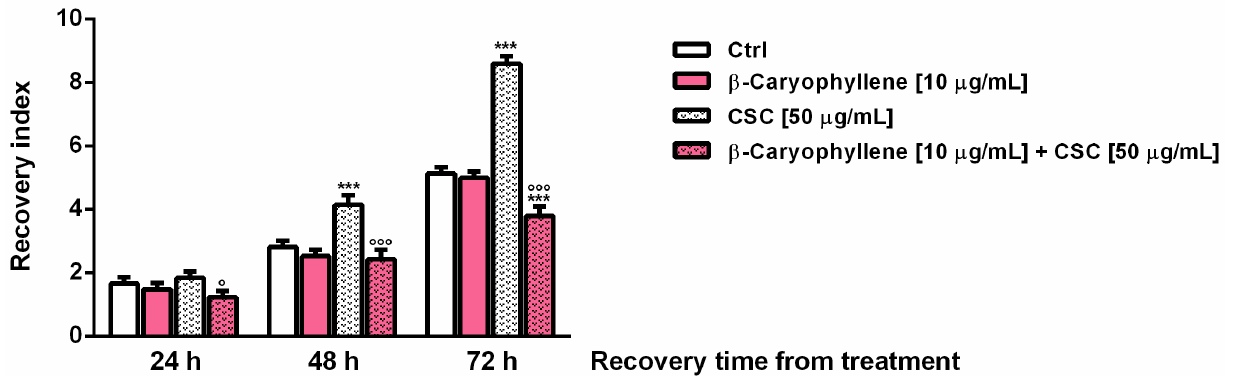
Figure 6. Effect of the co-treatment of β -caryophyllene and cigarette smoke condensate (CSC) in triple-negative breast cancer MDA-MB-468 cells after 24 h exposure and subsequent 72 h cell recovery. Recovery abilities were expressed as a recovery index, which represents the ratio between the cell number at each time point of recovery and that achieved after 24 h treatment. Cell number was determined by trypan blue exclusion assay at each time point. Data are displayed as mean ± SE of at least two experiments with at least three technical replicates ( n = 6). *** p < 0.001, significant lowering of cell viability the respect to the control (ANOVA + Dunnett’s multiple comparison post-hoc test). °°° p < 0.001, significant difference the respect to CSC (Student’s t -test).